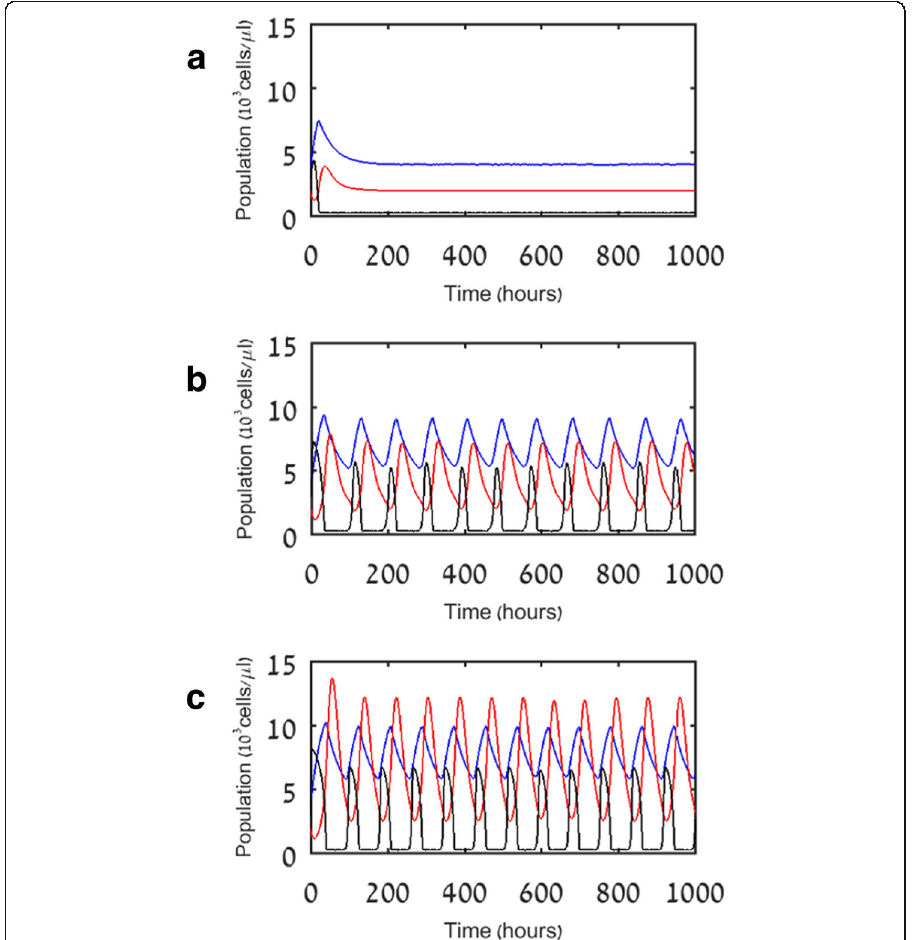
Fig. 2 Simulation results of model V1 for pathogens differing in growth rate. Results are shown for three cases of pathogen growth rate, p P : a mild pathogens (p P =1); b moderate pathogens (p P =1.5); c aggressive pathogens (p P =2). Blue, red, and black lines indicate myeloid cells (M), lymphocytes (L), and pathogen (P),